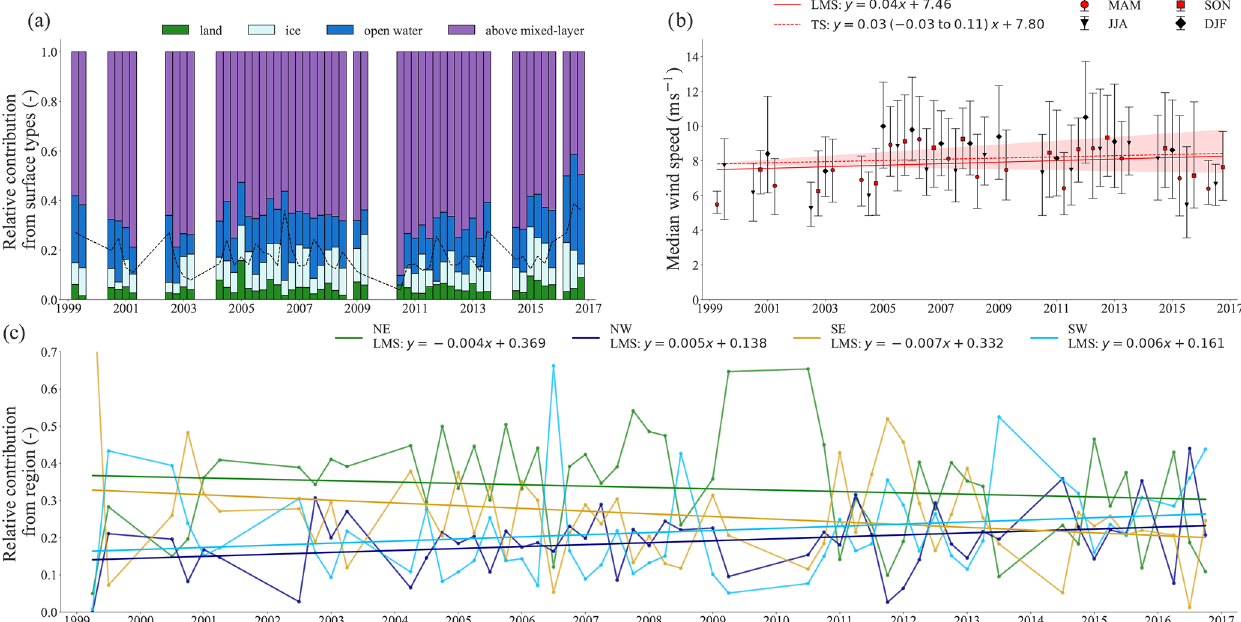
Figure 3. Long-term trends in (a) the relative contribution of the accumulated time per season air parcels spent above land, ice, and open water (whilst within the ML) and above the ML. (b) Median wind speed of air parcels located within the ML. (c) The relative contribution from the four different regions. The dashed black line in panel (a) presents the proportion of accumulated seasonal times for open water. For panel (b) , the dashed red line represents the Theil–Sen slope (TS) of the seasonal medians. The error bars denote the length of the 25th and 75th percentile values. The red shaded area denotes the associated 90% confidence interval of the TS slope. The solid lines in panels (b) and (c) display the least mean square (LMS) regression fit. Note the scale for the y axis of panel (c) is reduced to 0.6, and the south-east contribution in spring 1999 is ∼ 94%.